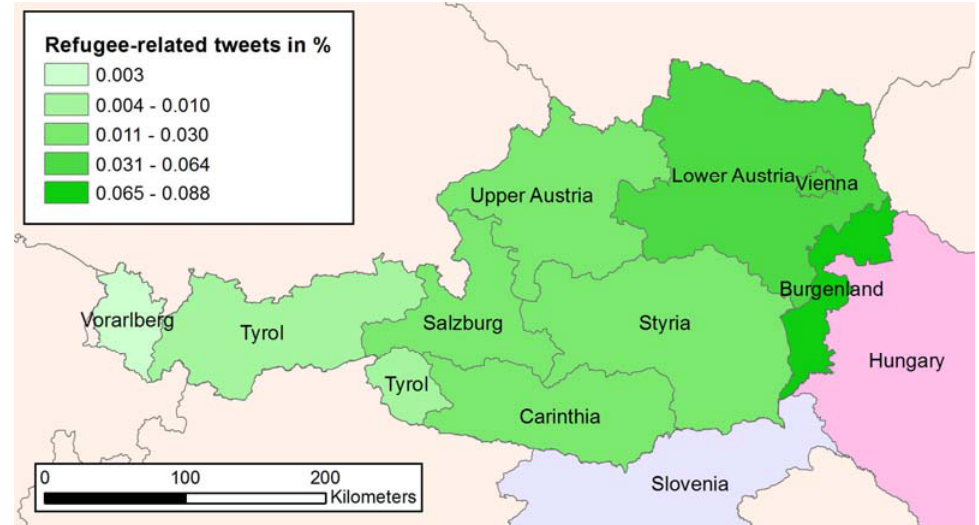
Figure 13. Percentage of refugee related tweets in Austrian provinces. Table 1. Estimation results for percentage of refugee related tweets in Austrian provinces. Coefficient Std. Err. t Sig.